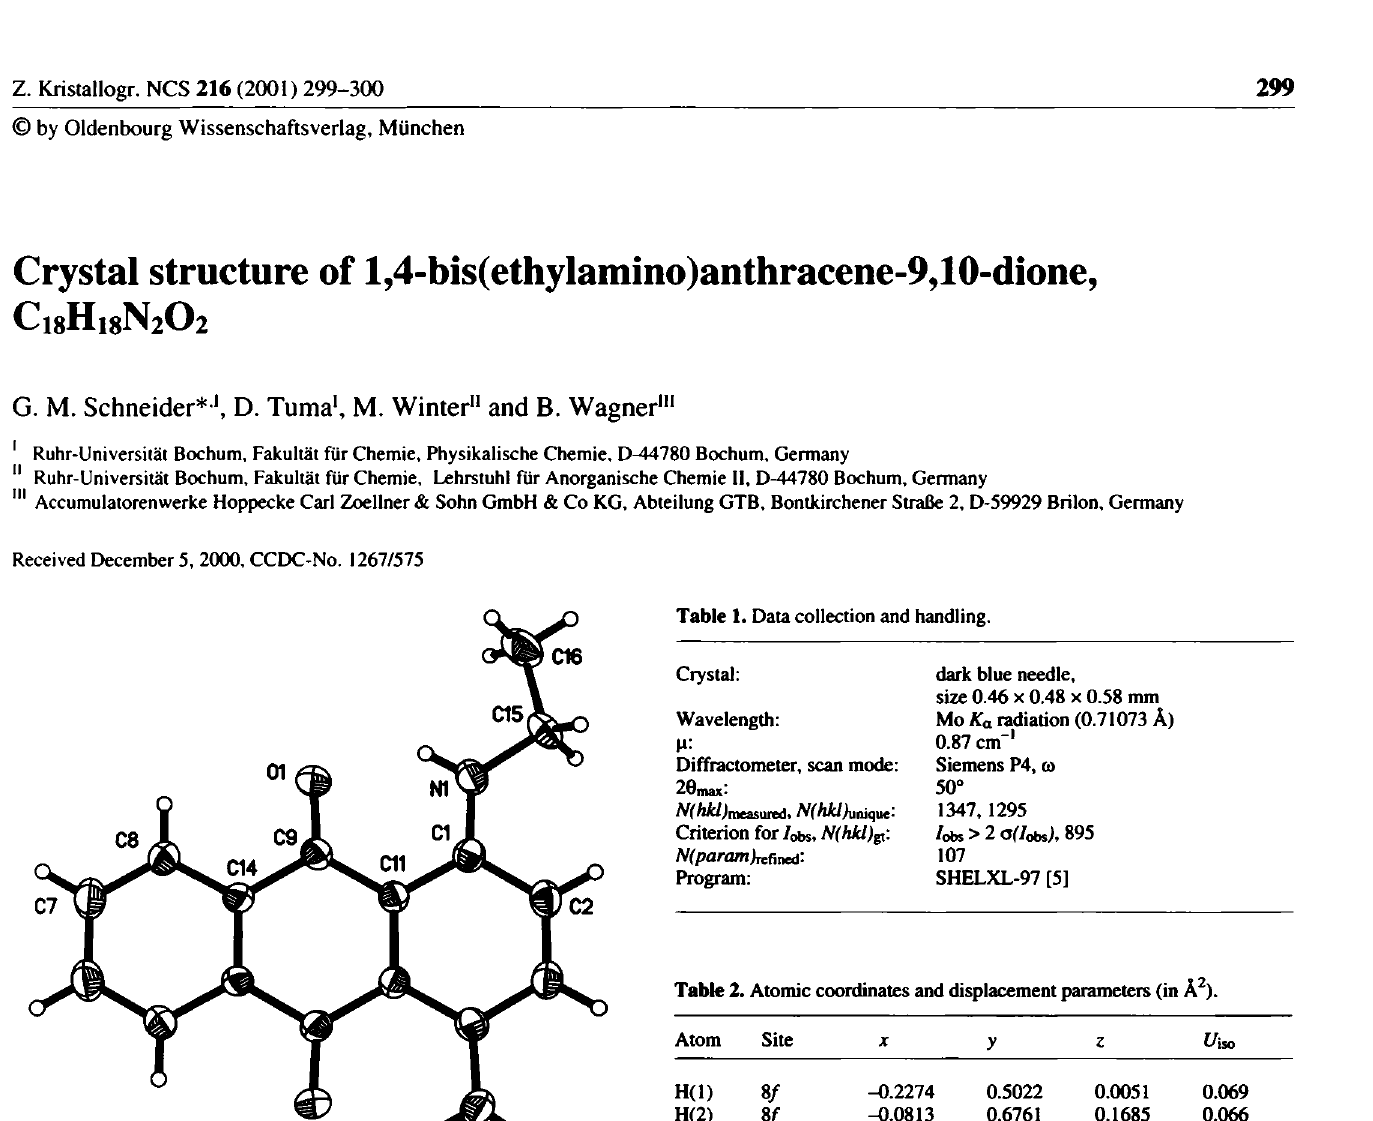
Table 2. Atomic coordinates and displacement parameters (in A 2